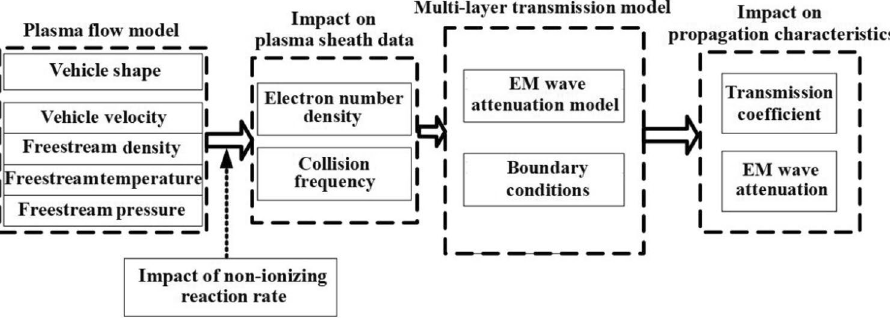
Figure 2. Combined simulation of plasma flow and multi-layer transmission